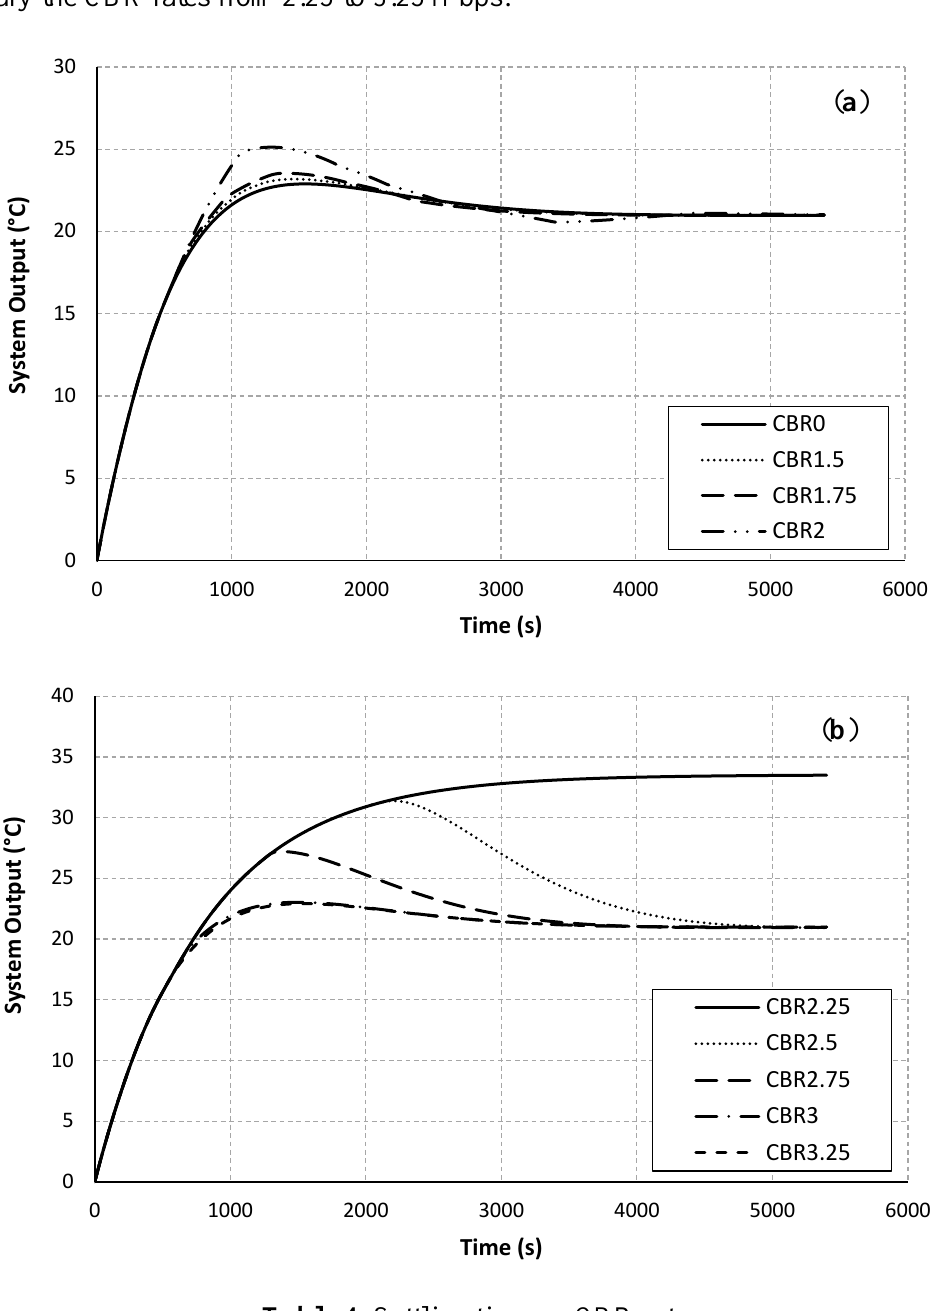
Figure 4. The system output at the plant. ( a ) Vary the CBR rates from 0 to 2.00 Mbps. ( b ) Vary the CBR rates from 2.25 to 3.25 Mbps.